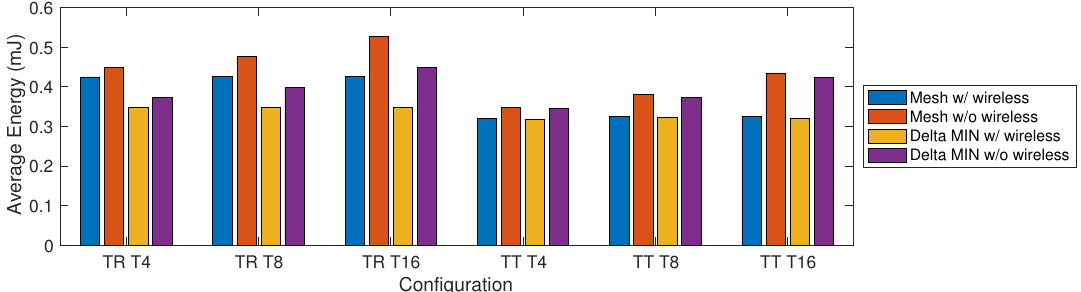
Figure 24. Average energy (mJ) in non-saturated conditions for Delta MIN and mesh topologies of size 256.